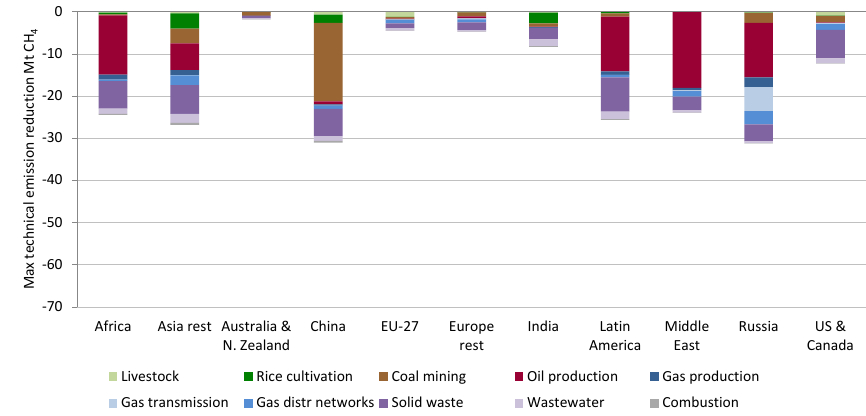
Fig. 5. CH 4 maximum technical reduction in 2030 by sector and world region.